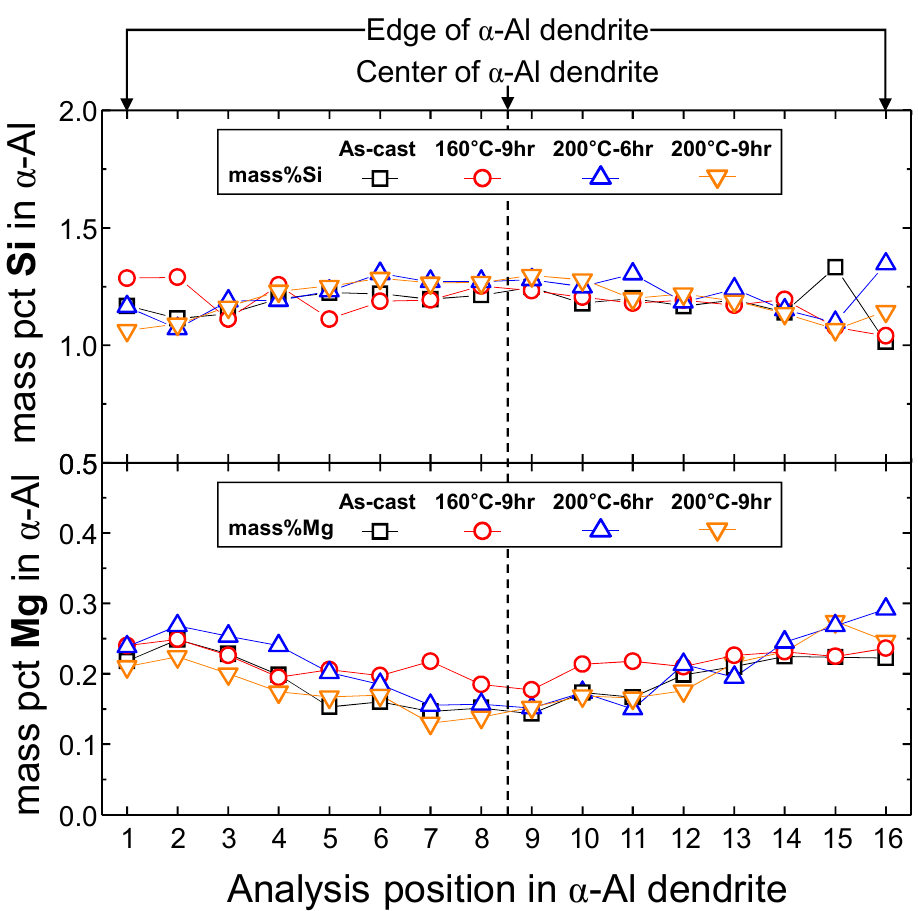
Figure 6. Si and Mg concentration profiles in α -Al dendrites at different T5 heat treatment